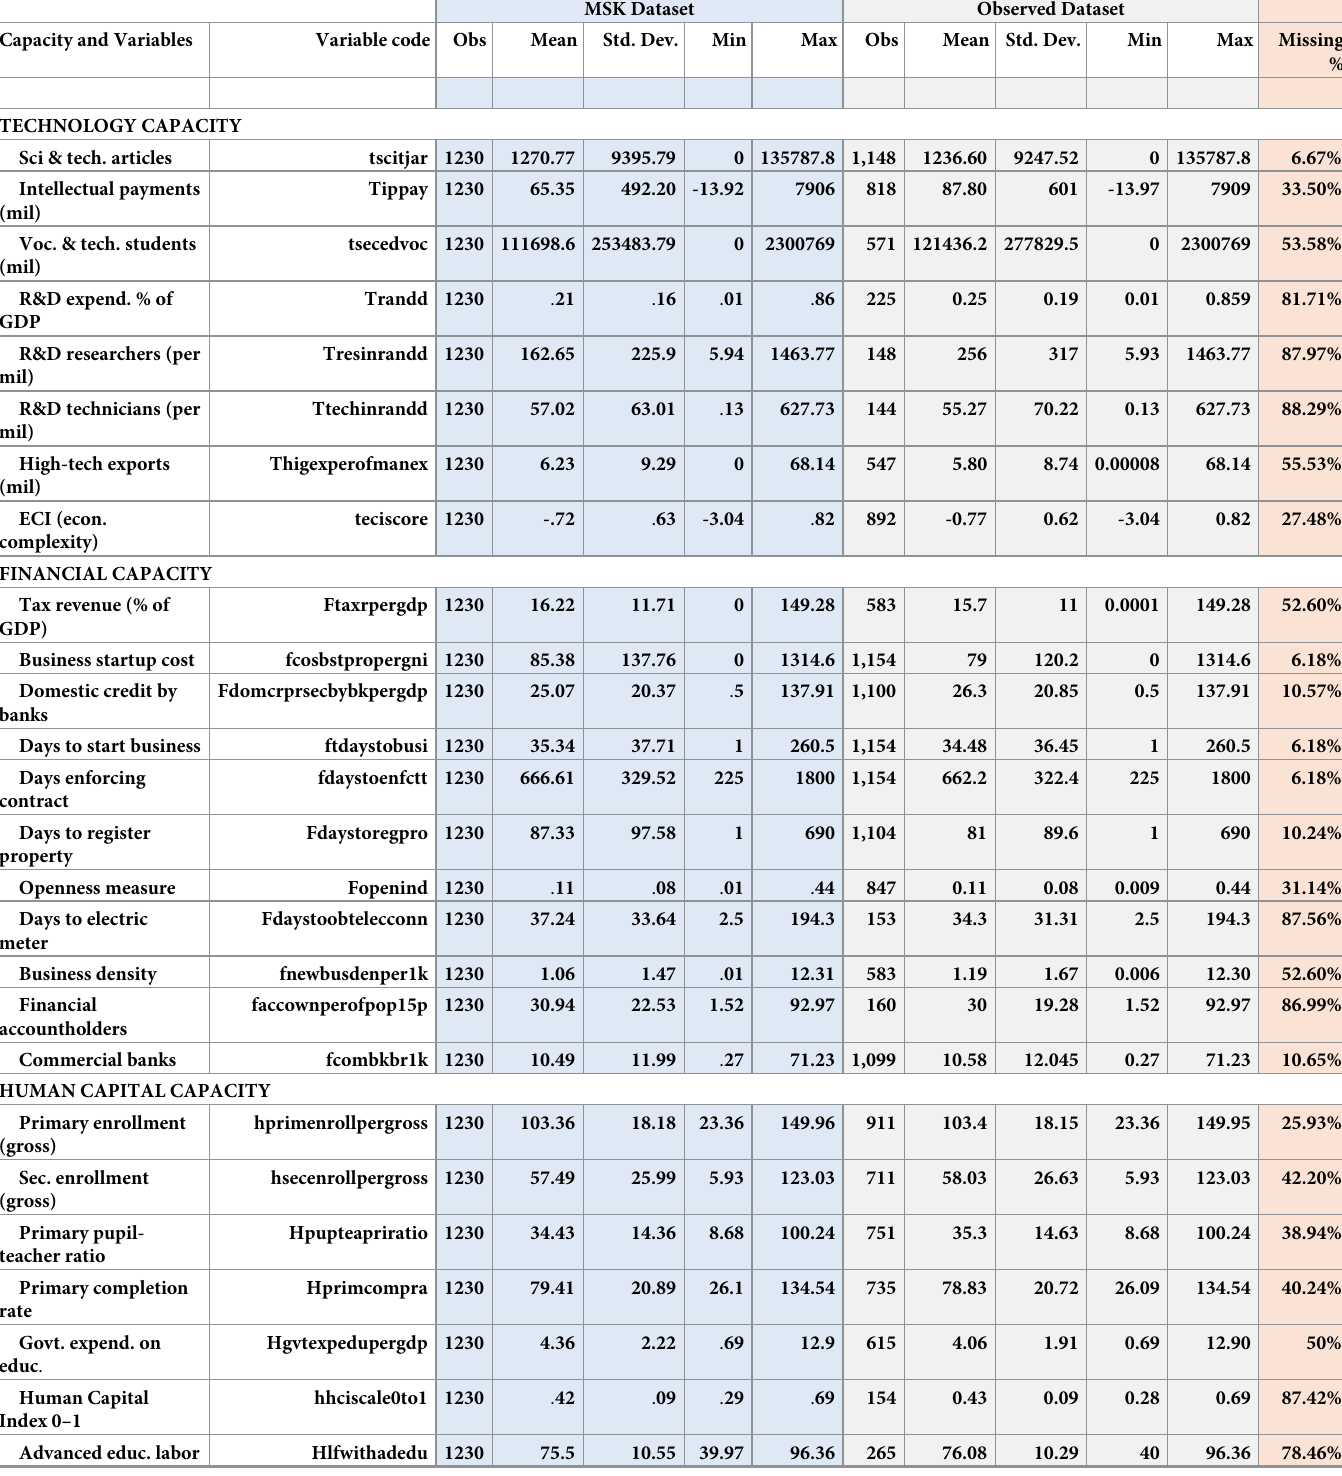
Table 1. Descriptive statistics of new MSK dataset vs. incomplete observed dataset (for more details on the variables, please consult S2